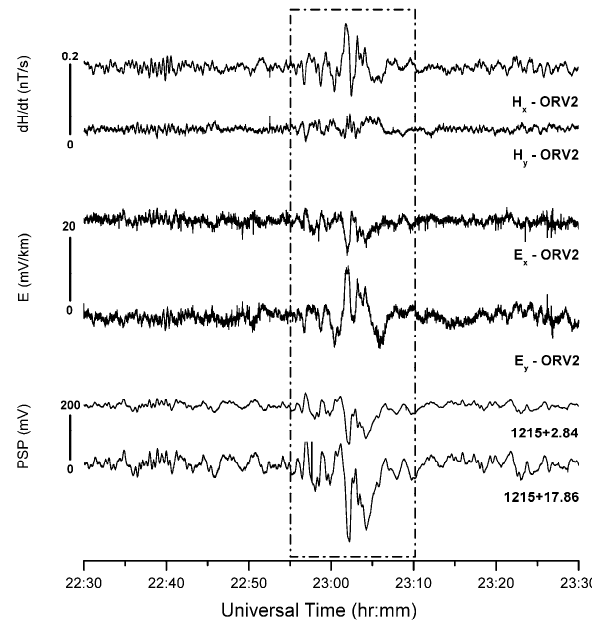
Fig. 4. Field data recorded on 8 October 2003: magnetically ori- Figure 4. ented north-south ( E x ) and east-west ( E y ) components of the sur- face geoelectric field from MT site ORV2; magnetically oriented north-south ( dH x / dt ) and east-west ( dH y / dt ) components of the ge- omagnetic field from MT site ORV2; PSP recordings from test posts 1215+2.84 and 1215+17.86. The boxed area emphasizes a geomag- netic disturbance. Geoelectric field data was decimated and plotted at 1Hz.